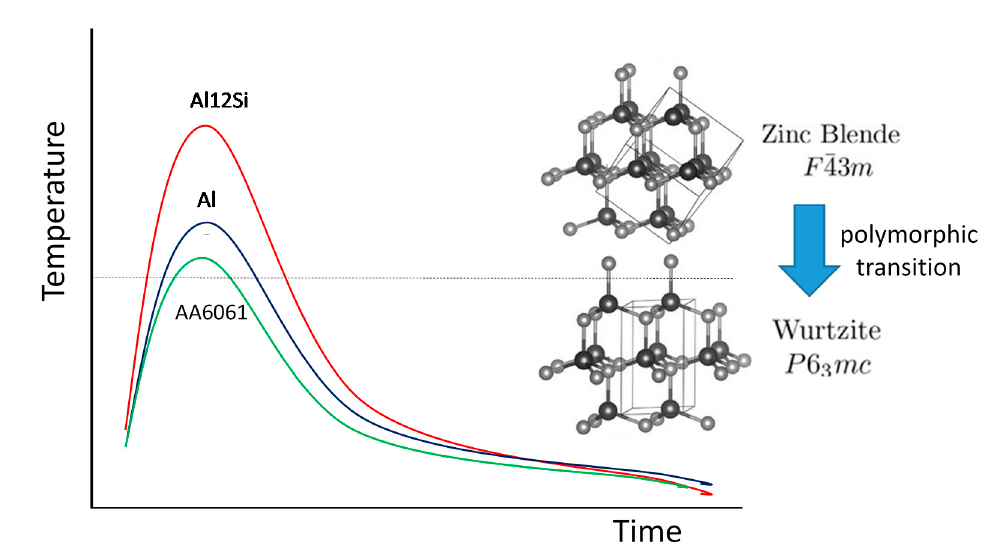
Figure 10. Particle temperature achieved against time for the different aluminium alloys used and representative temperature of the polymorphic transition or AlN, showing the time in which the aluminium alloy is at a temperature at which AlN is in its cubic structure (Zinc Blende).